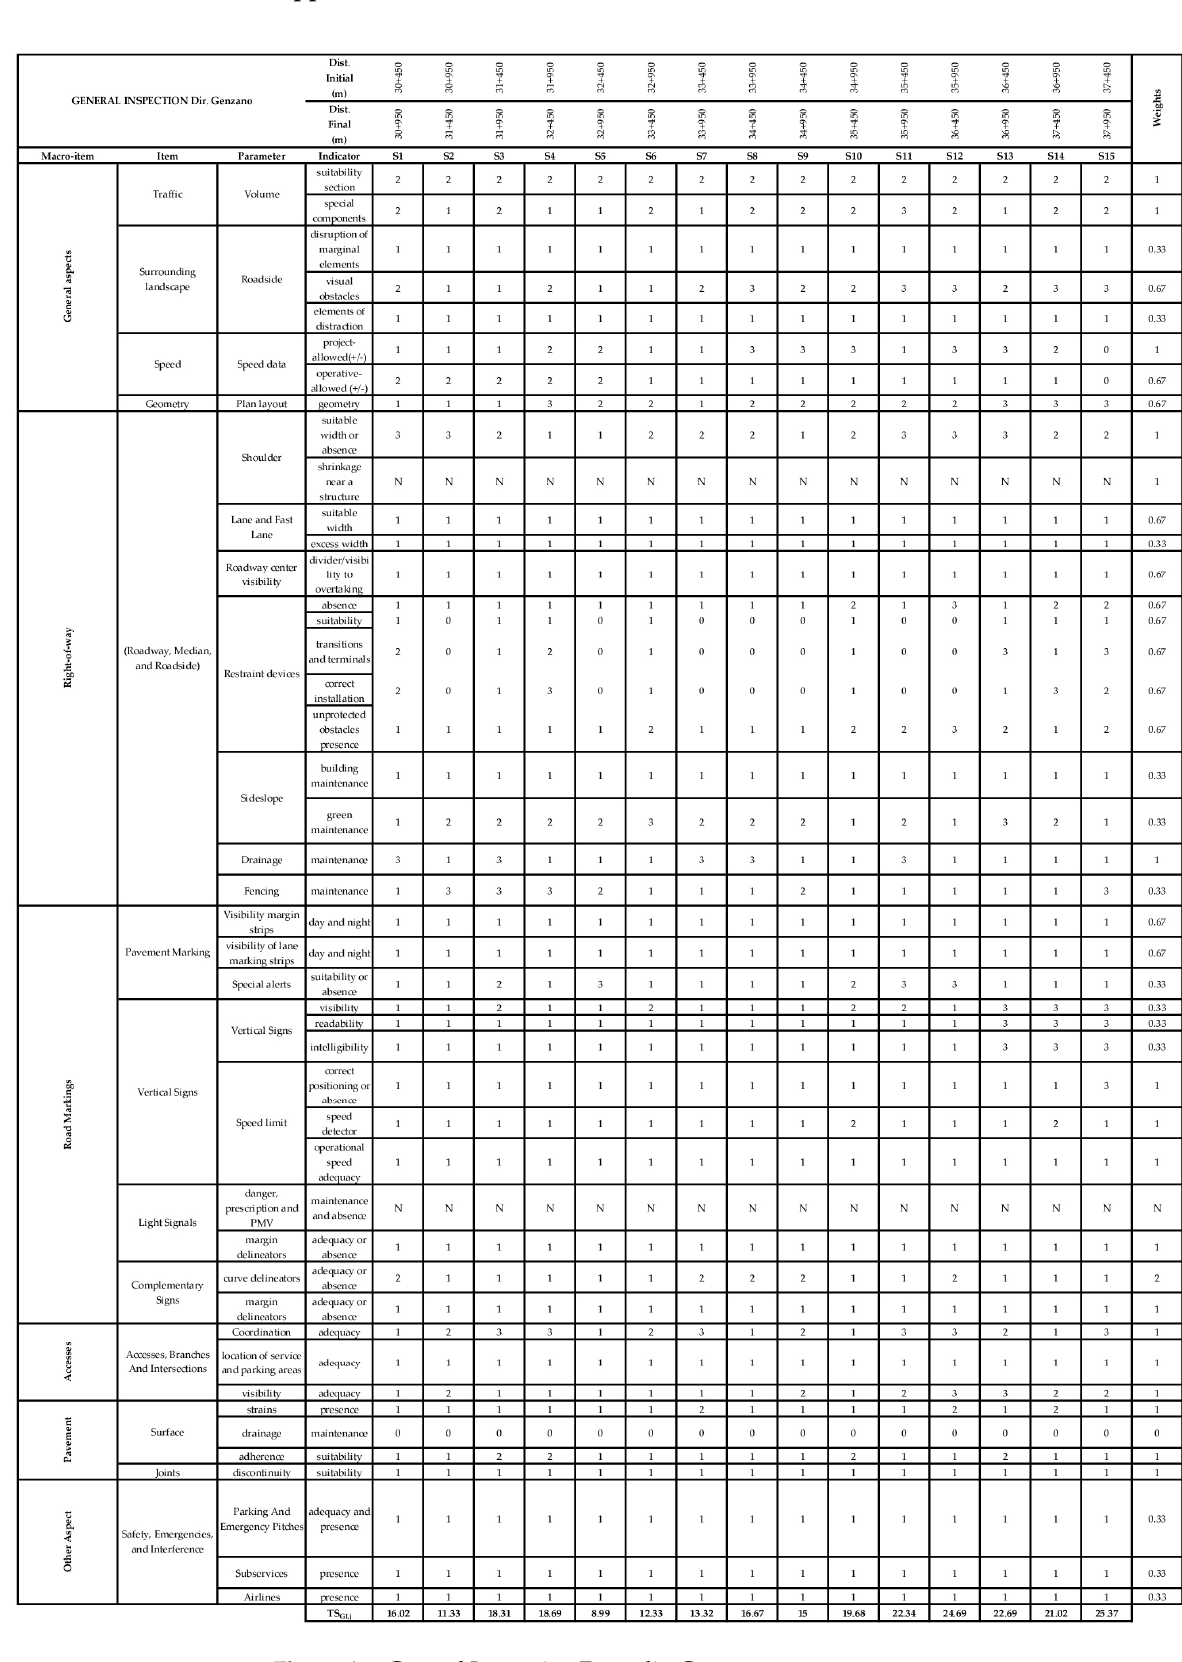
Figure A1. General Inspection Form dir. Genzano.